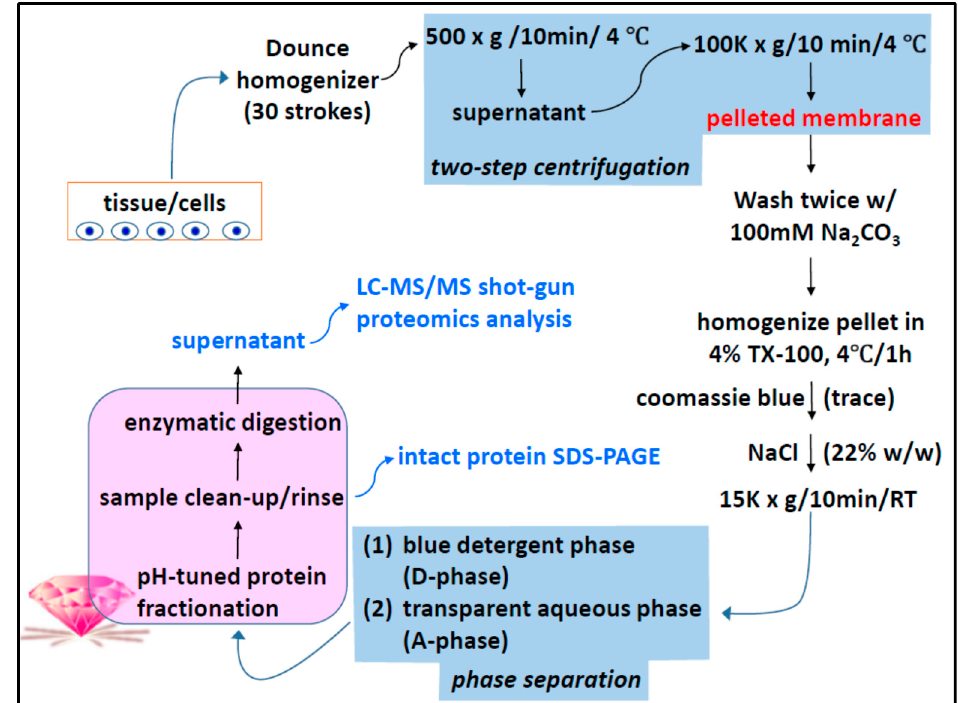
Figure 10. Experimental overview of membrane proteome preparation for MS proteomics identification with the SPEED platform.